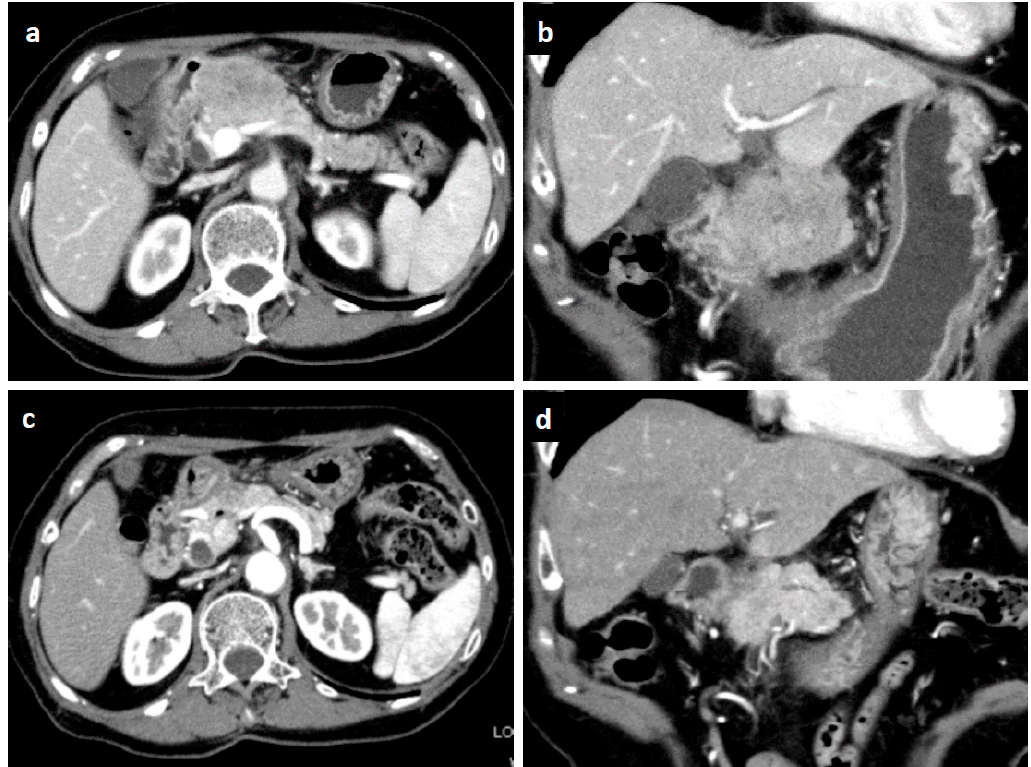
Figure 1. Enhanced computed tomography. An irregular-margined, low-attenuated mass 5 cm in size was seen at the pancreas head (horizontal view ( a ), coronal view ( b )). One month after the histological diagnosis, the pancreatic mass was markedly shrunken spontaneously (horizontal view ( c ), coronal view ( d )).